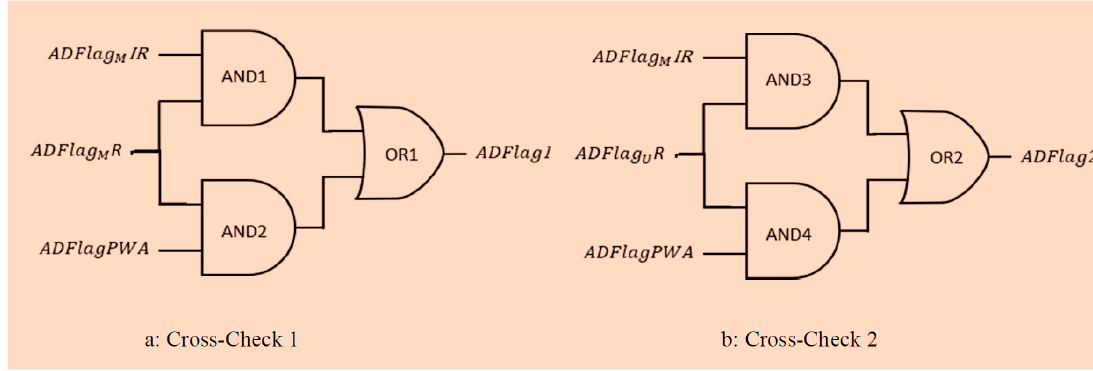
Figure 12. Algorithm logic gates scheme for cross-checking outputs of method1-PSD ( a ) and method2-PWA ( b ).